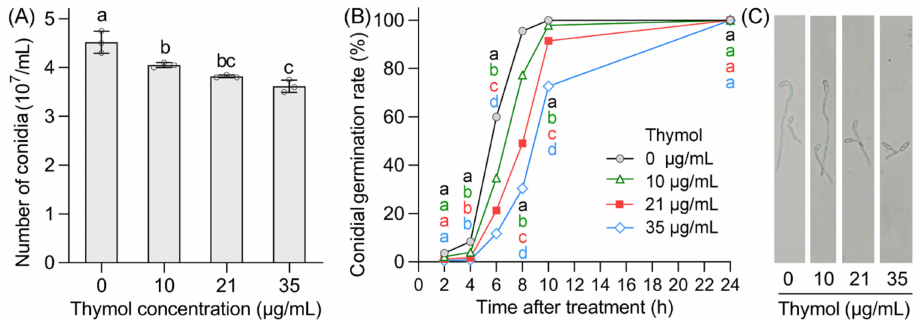
Figure 8. The effect of thymol on conidia production and conidial germination of FON . ( A ) The mycelia were cultured in Bilay’s medium containing thymol (0, 10, 21, and 35 µ g/mL) to produce conidia for 24 h, followed by counting the number of produced conidia. Different lowercase letters indicated significant difference among different treatments (ANOVA, n = 3, p < 0.05). ( B ) The conidia were allowed to be germinated under thymol (0, 10, 21, and 35 µ g/mL) treatment. The germinated conidia were counted at specific time points, respectively. Different lowercase letters indicated significant difference among different treatments at each time point (ANOVA, n = 3, p < 0.05). For each time point, the colors of different lowercase letters correspond to the colors of different legends indicating different treatments. ( C ) Microscopic observation of conidial germination after thymol treatment (0, 10, 21, and 35 µ g/mL) for 6 h. Bars indicated SD of three